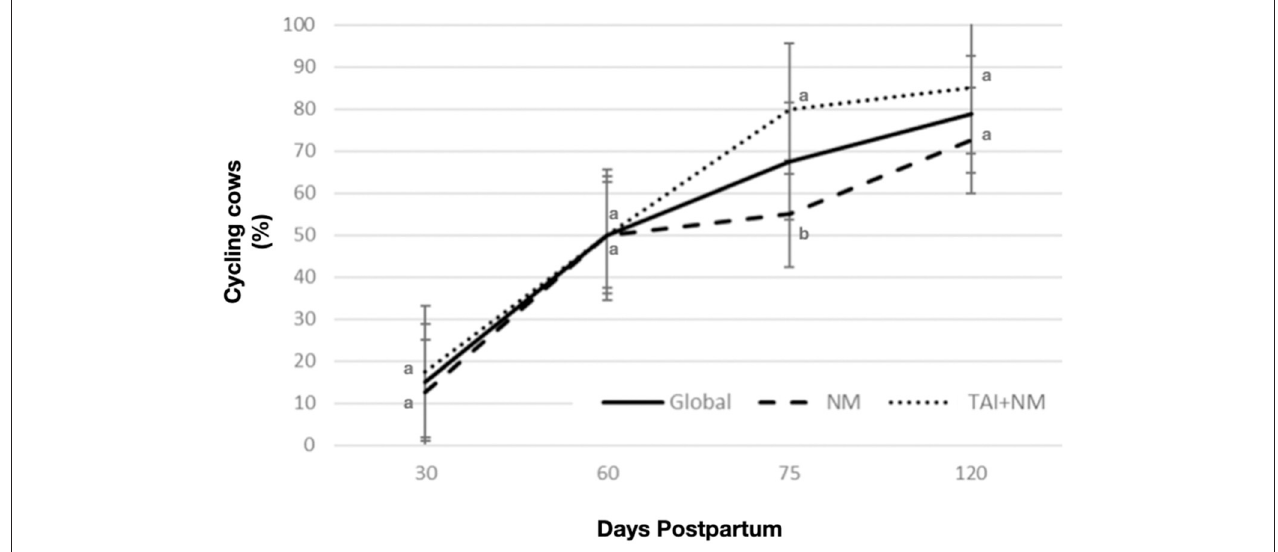
FIGURE 3 | Percentages of cycling cows at different postpartum days global and by breeding program. The bar error depicts the difference between percentages. Different letters between days postpartum are statistically significant ( P < 0.01).